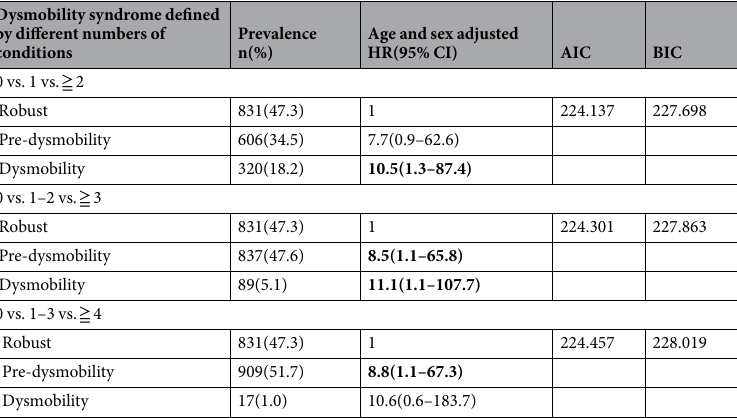
Table 4. Prevalence and mortality risk by different selected numbers of dysmobility components. AIC, Akaike Information Criterion; BIC, Bayesian information